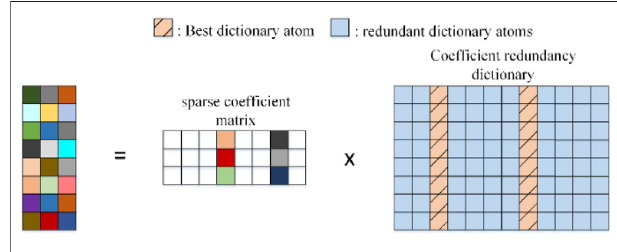
FIGURE 1 | Sparse